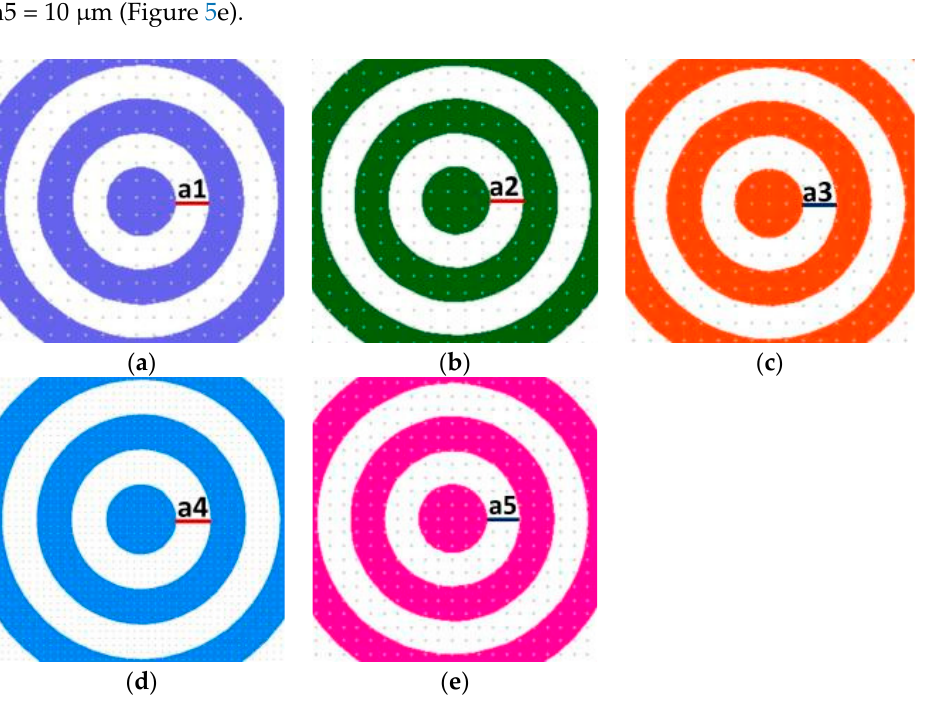
Figure 5. Photolithographic masks for multilevel axicon of order zero ( a – e ) M1-M5 for 5 photolithographic processes with different ring widths: ( a ) a1 = 160 μ m, ( b ) a2 = 80 μ m, ( c ) a3 = 40 μ m, ( d ) a4 = 20 μ m, ( e ) a5 = 10 μ m.